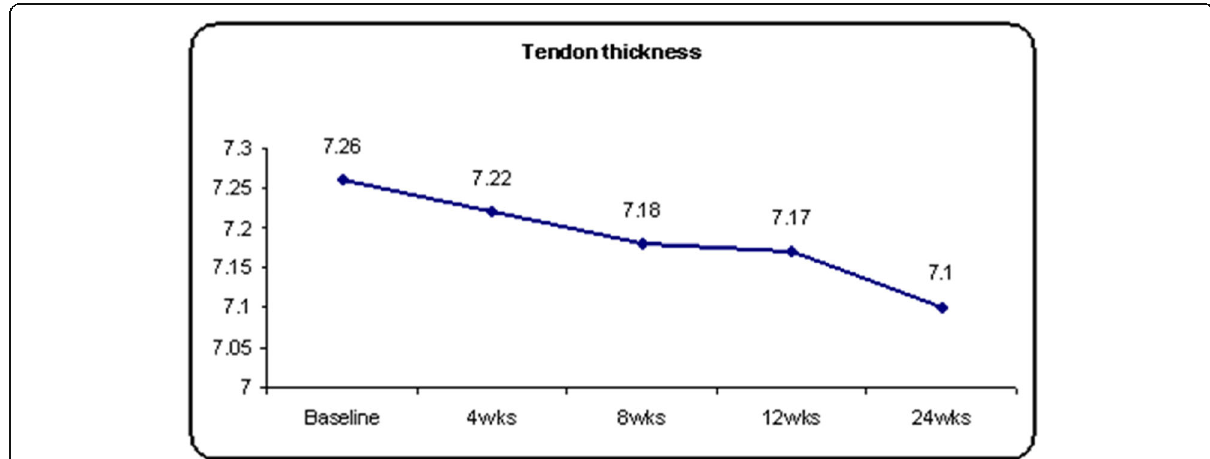
Fig. 6 A graph displaying the difference in the tendon thickness throughout the points of